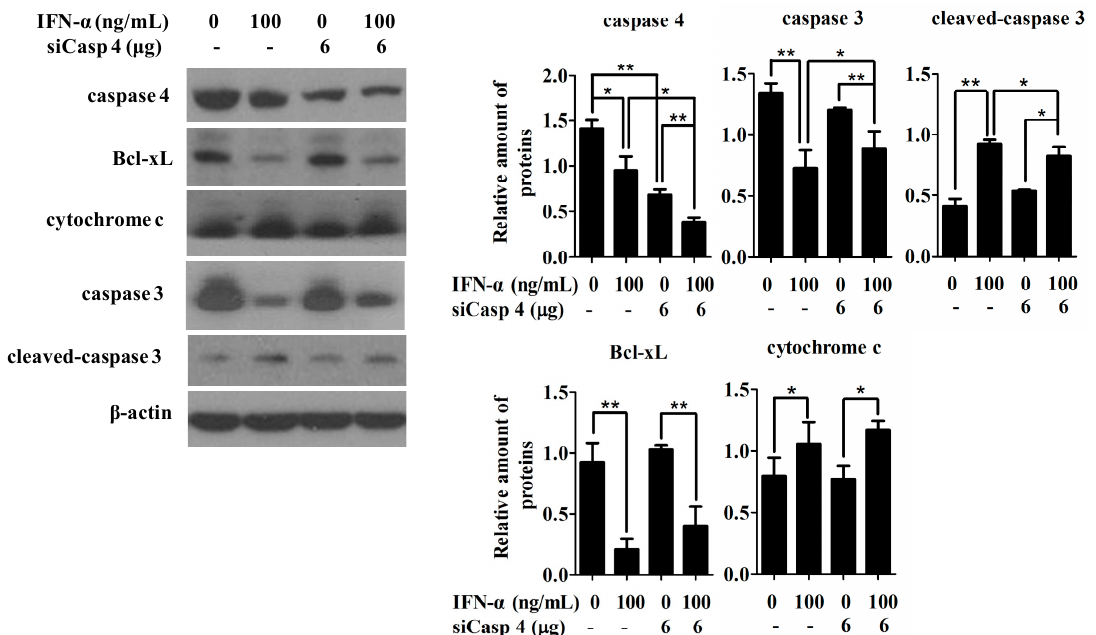
Figure 6. Inhibiting endogenous caspase 4 by siCasp 4 weakens the caspase 3 cleavage, but does not block IFN- α -mediated activation of the mitochondrial apoptotic pathway. HeLa cells were transiently transfected with either control siRNA or siCasp 4 in the presence or absence of 100 ng/mL IFN- α . After 48 h incubation, the whole-cell lysates were harvested, probed with anti-caspase 4, anti-Bcl-xL, anti-cytochrome c, anti-caspase 3, and anti-cleaved-caspase 3 antibodies, and subjected to Western blot analysis (left panel). β -actin gene expression is served as an internal control. Quantitation of the relative gene expression of the individual band detected by Western blot was performed using the Image J program. Each bar is represented as mean ± SD from three independent experiments that have been adjusted based on β -actin expressions. After statistical analysis, results were considered to be significant as p < 0.05 (*) or p < 0.01(**).